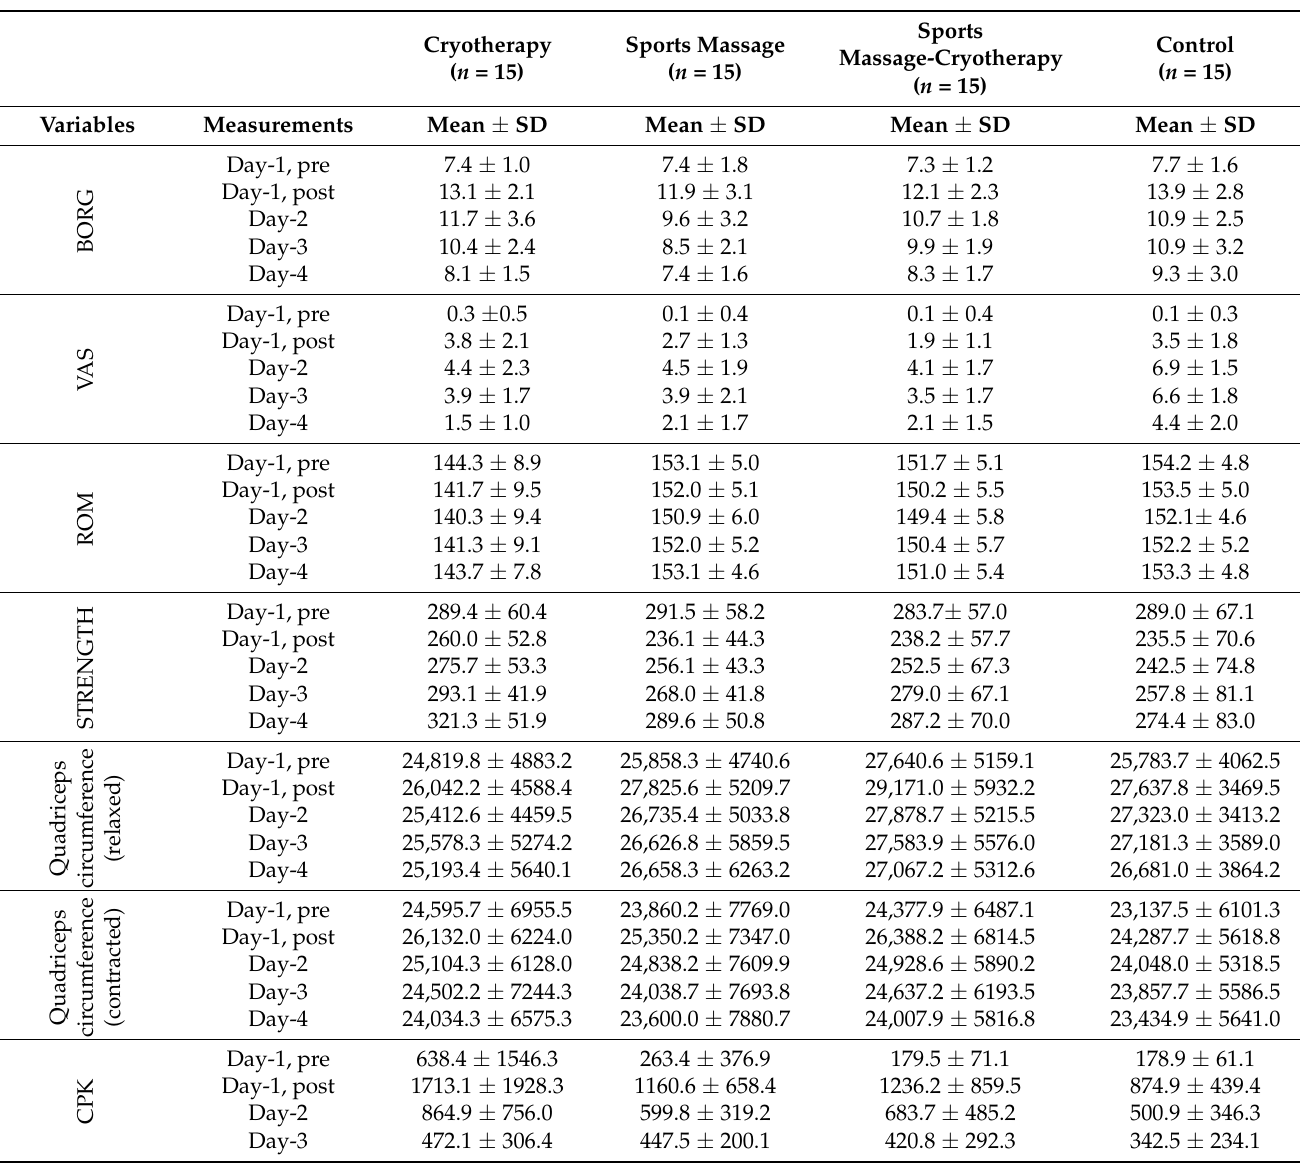
Table 1. Functional data and symptoms before and after the application of the fatigue protocol and therapeutic interventions in amateur athletes ( n =